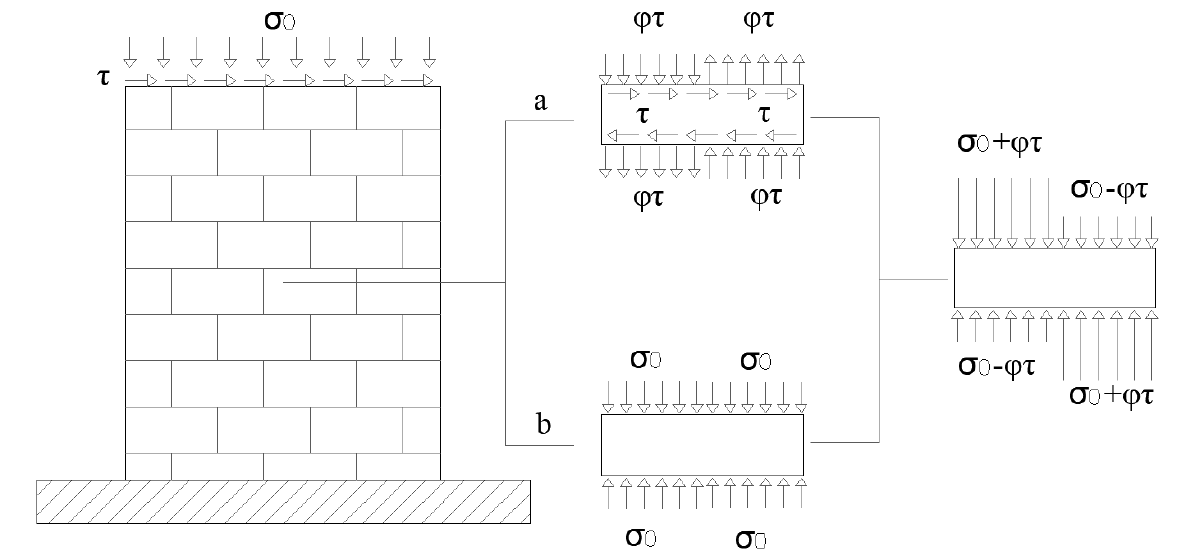
Figure 4. Distribution of the normal stress according to Mann and Muller (From Calderini et al. [22]).